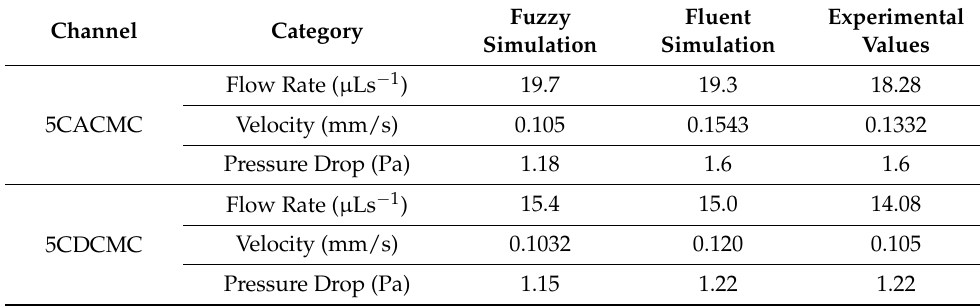
Table 7. Overall Result